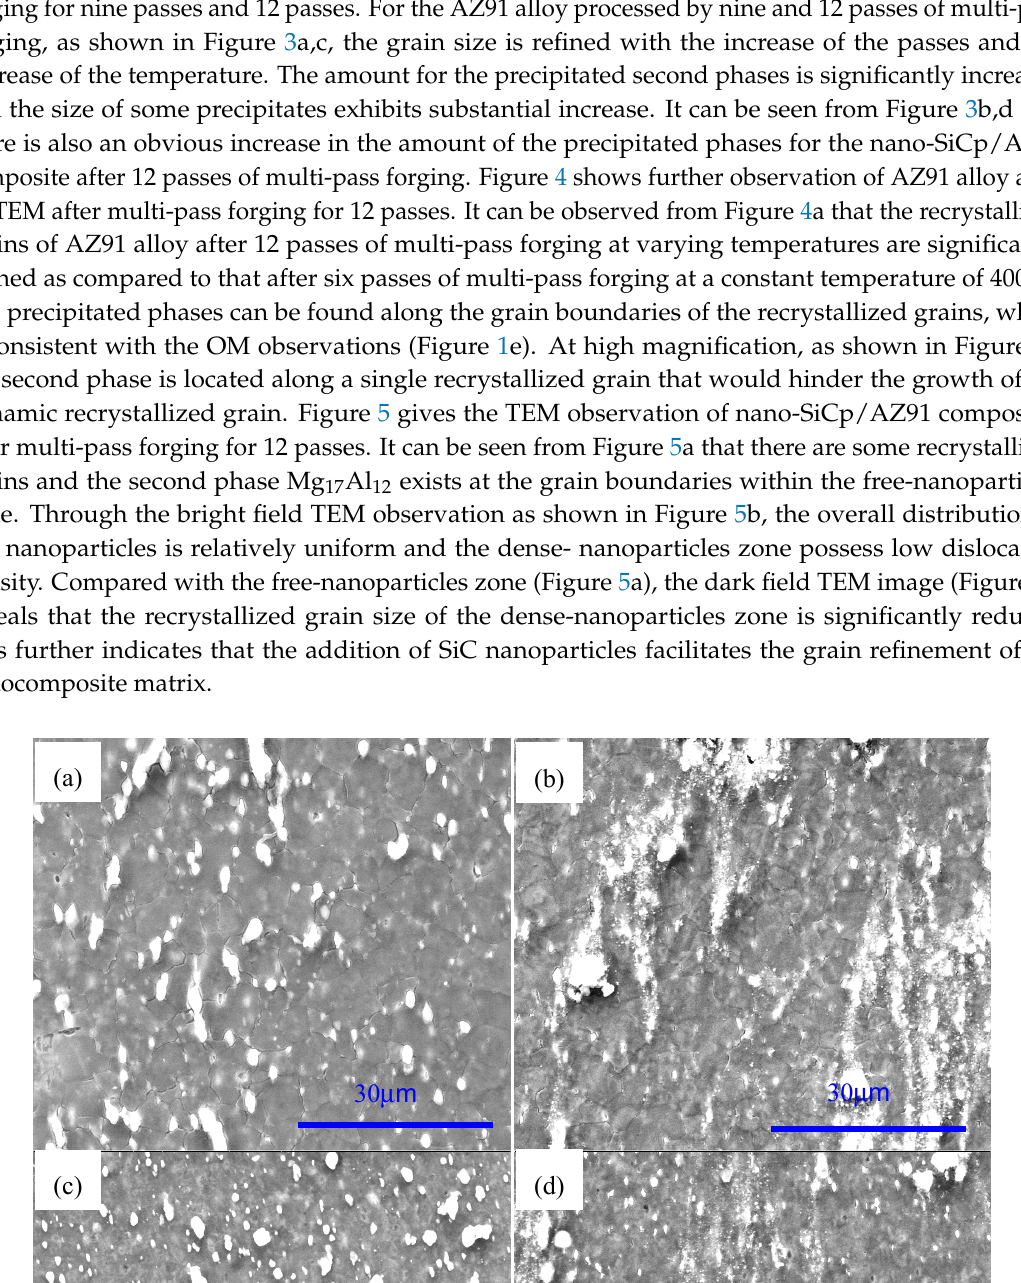
Figure 2. Grain sizes of AZ91 alloy and nano-SiCp/AZ91 composites after multi-pass forging for different passes.